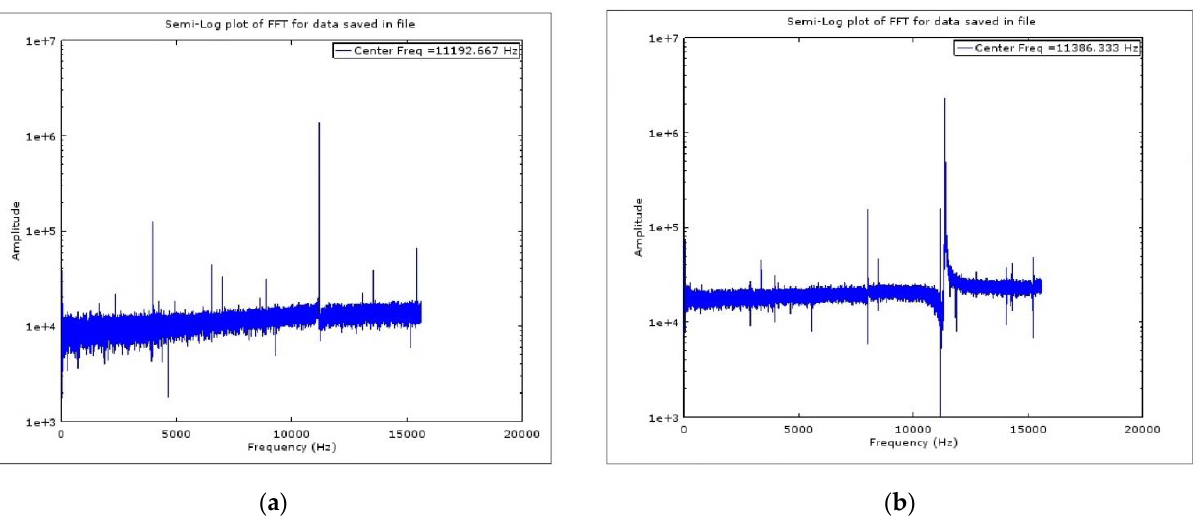
Figure 8. Fast Fourier Transformation for the dynamic response: ( a ) drive; ( b ) sense. Table 2. Comparison of simulation and experimental frequency results.